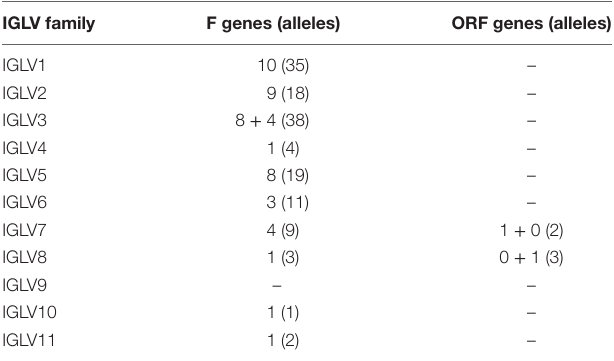
TaBle 4 | List of all functional and open reading frame (ORF) IGLV genes and alleles in the IGLV allele library.